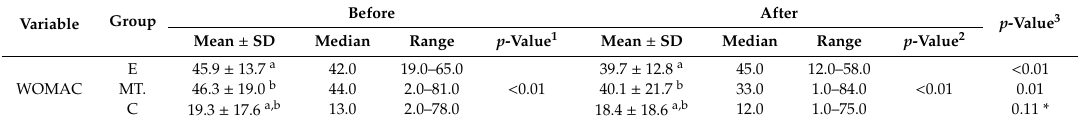
Table 3. Results of WOMAC measure in E, MT, and C groups of participants.